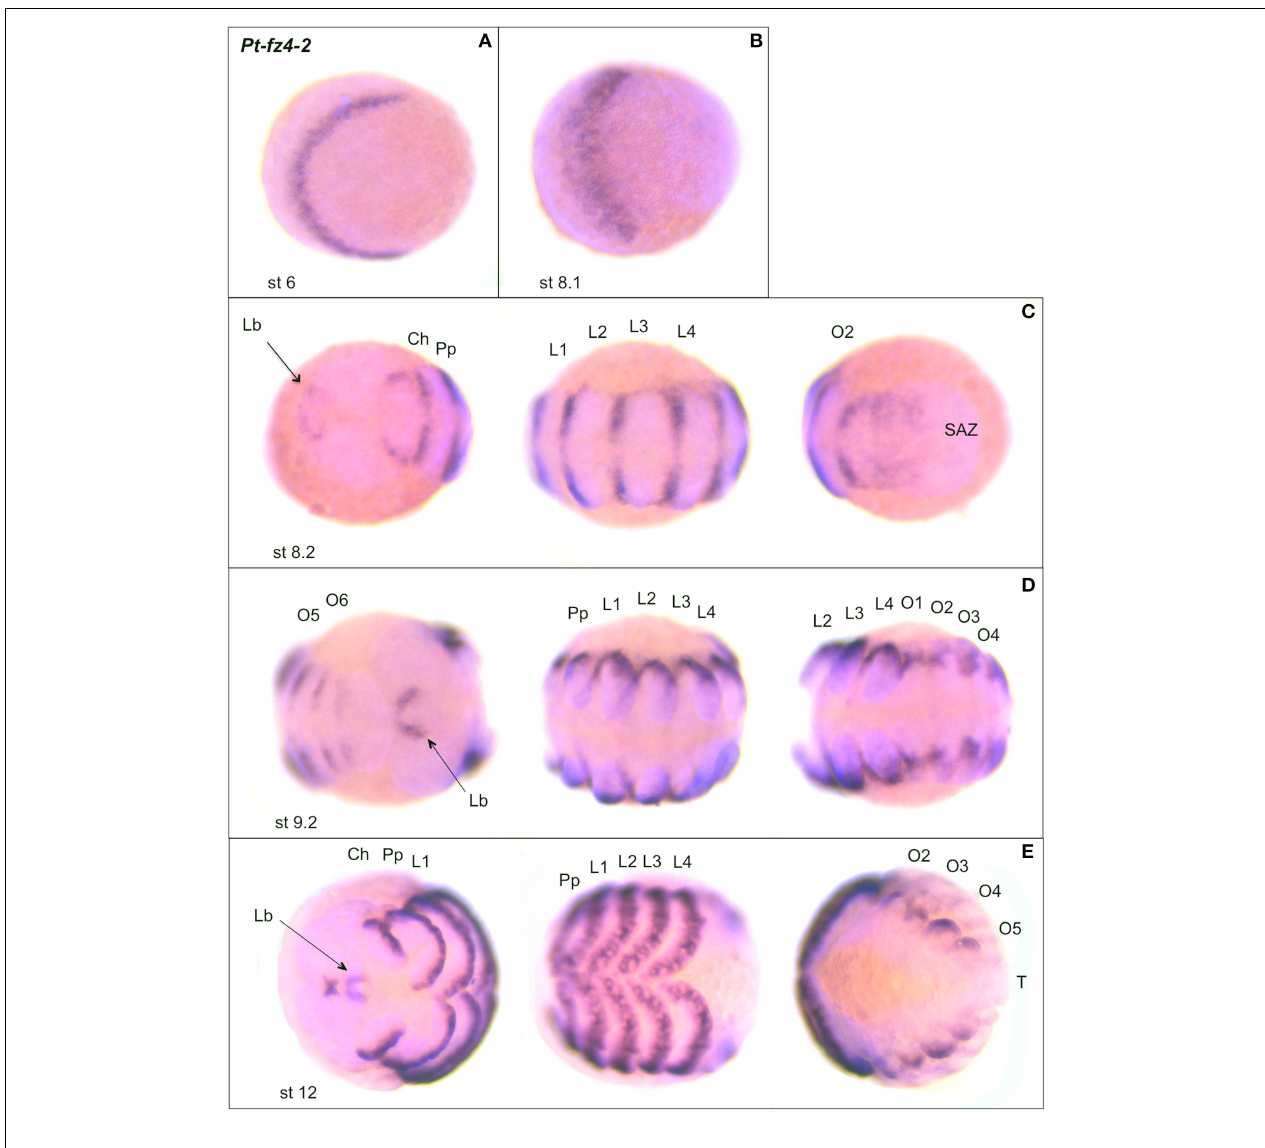
FIGURE 9 | Expression of Parasteatoda fz4-2 . In all panels anterior is to the left. (A,B) Early germ band (anterior prosoma). (C) Germ band (from left to right: anterior prosoma, posterior prosoma and opisthosoma/SAZ). (D) Germ band (posterior opisthosoma/SAZ and anterior prosoma, posterior